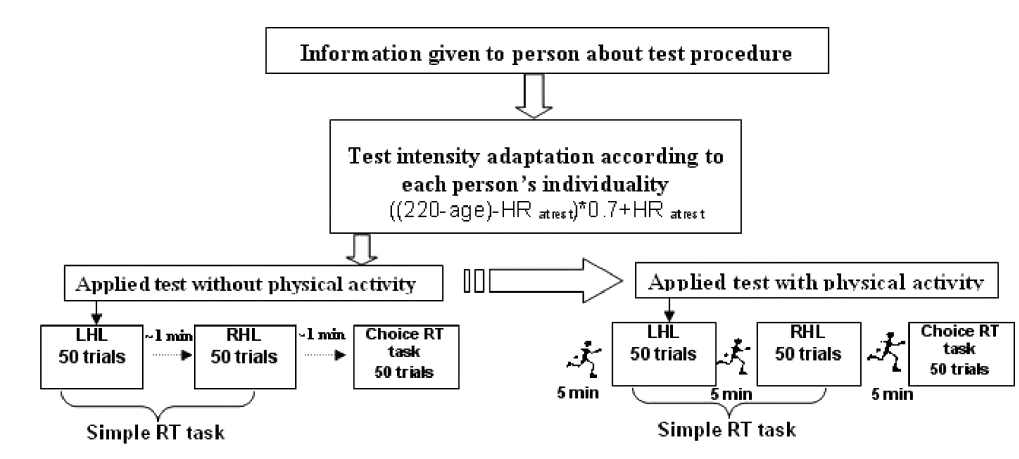
Figure 1. The reaction time test